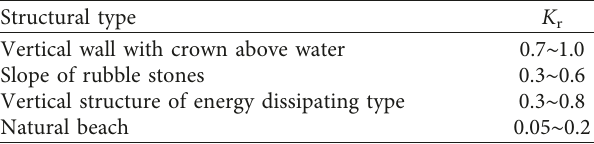
Figure 1: Comparison of the reflection coefficient K r for plane, dentated, and serrated vertical seawalls. Different periods are shown corresponding to d/L p 0.09; 0.15; 0.45 and H s /d 0.14. (cid:31) (cid:31) (adapted from [5]). Table 1: Approximate value of reflection coefficients